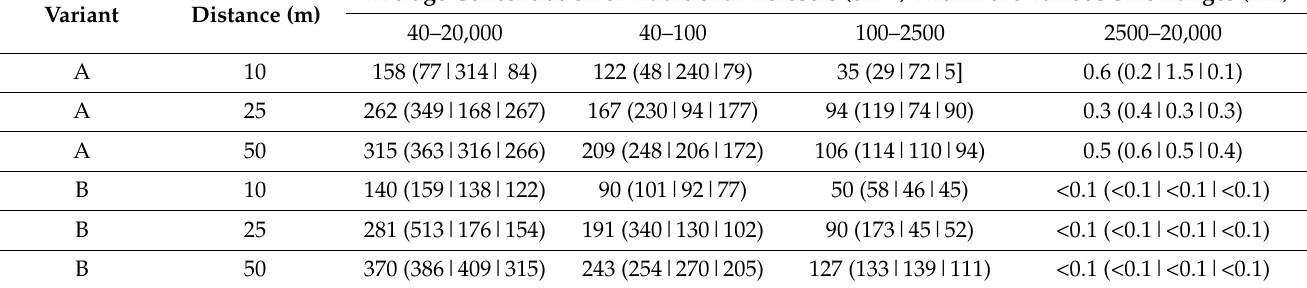
Table 2. Concentration of additional aerosols averaged over the left and right side walls and in the axis of the excavation at 150 cm, assuming that the consumption of solution by the aerosol generator is 1 cm 3 /min. The values for the left side wall, center and right side wall of the excavation are given in